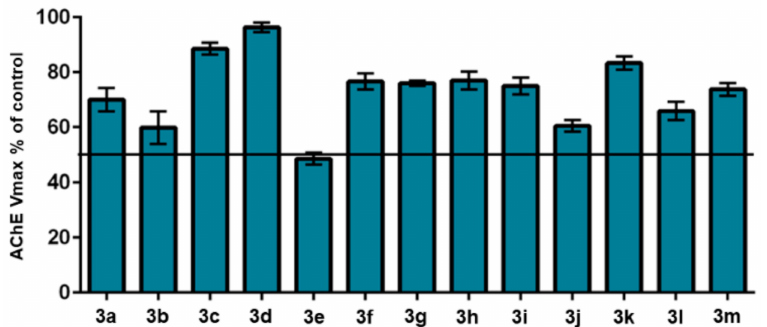
Figure 3. E ff ect of hybrid compounds on AChE activity (screened at 30 µ M). The result is expressed as AChE maximum velocity (Vmax) in the presence of the indicated compound relative to uninhibited enzyme (control).